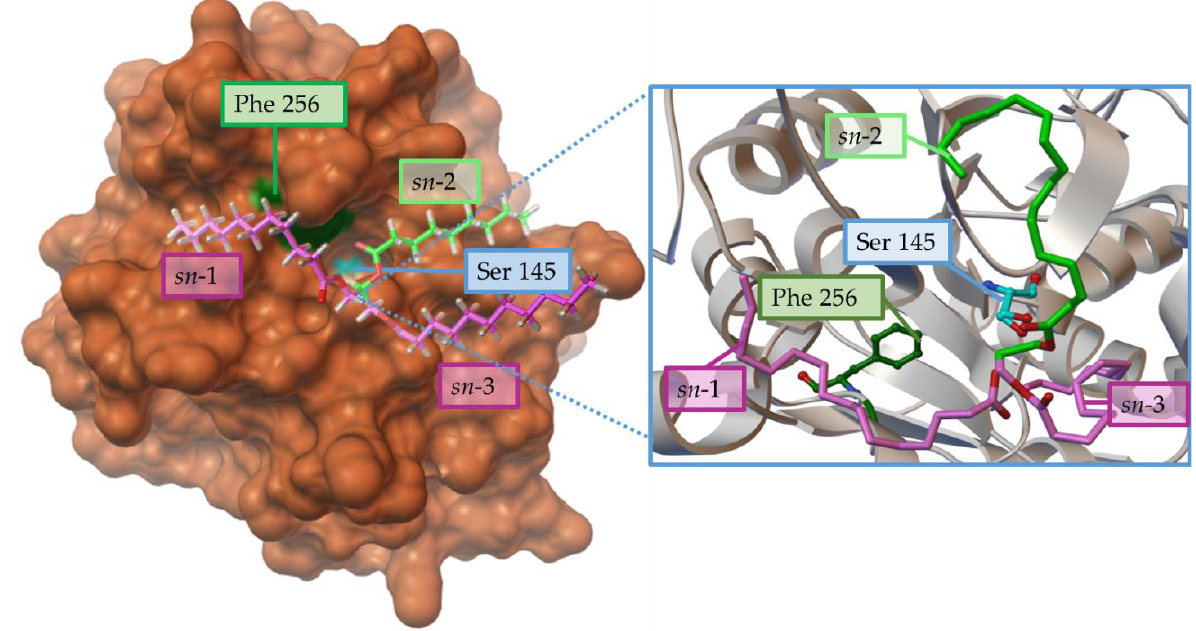
Figure 4. Steric effects of the residue Phe256 (Green) from Penicillium cyclopium lipase prevent the adequate interaction of sn-1 position (violet) in the substrate triacylglycerol (cyan) with the catalytic triad represented in orange, but this effect about the carboxyl carbon from the sn-2 position to the O(β) of Ser145. Structure from PDB 5ch8, using AutoDockTools 4.0 viewer and adapted from [102].